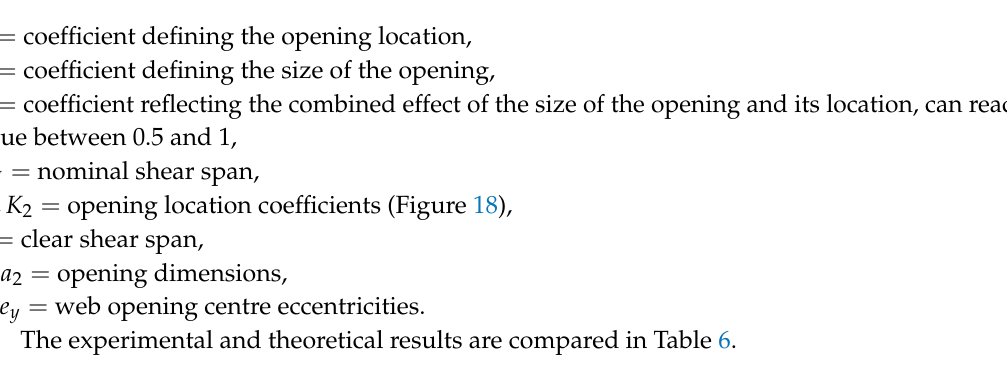
Table 6. Experimental and theoretical results for deep beams. Deep